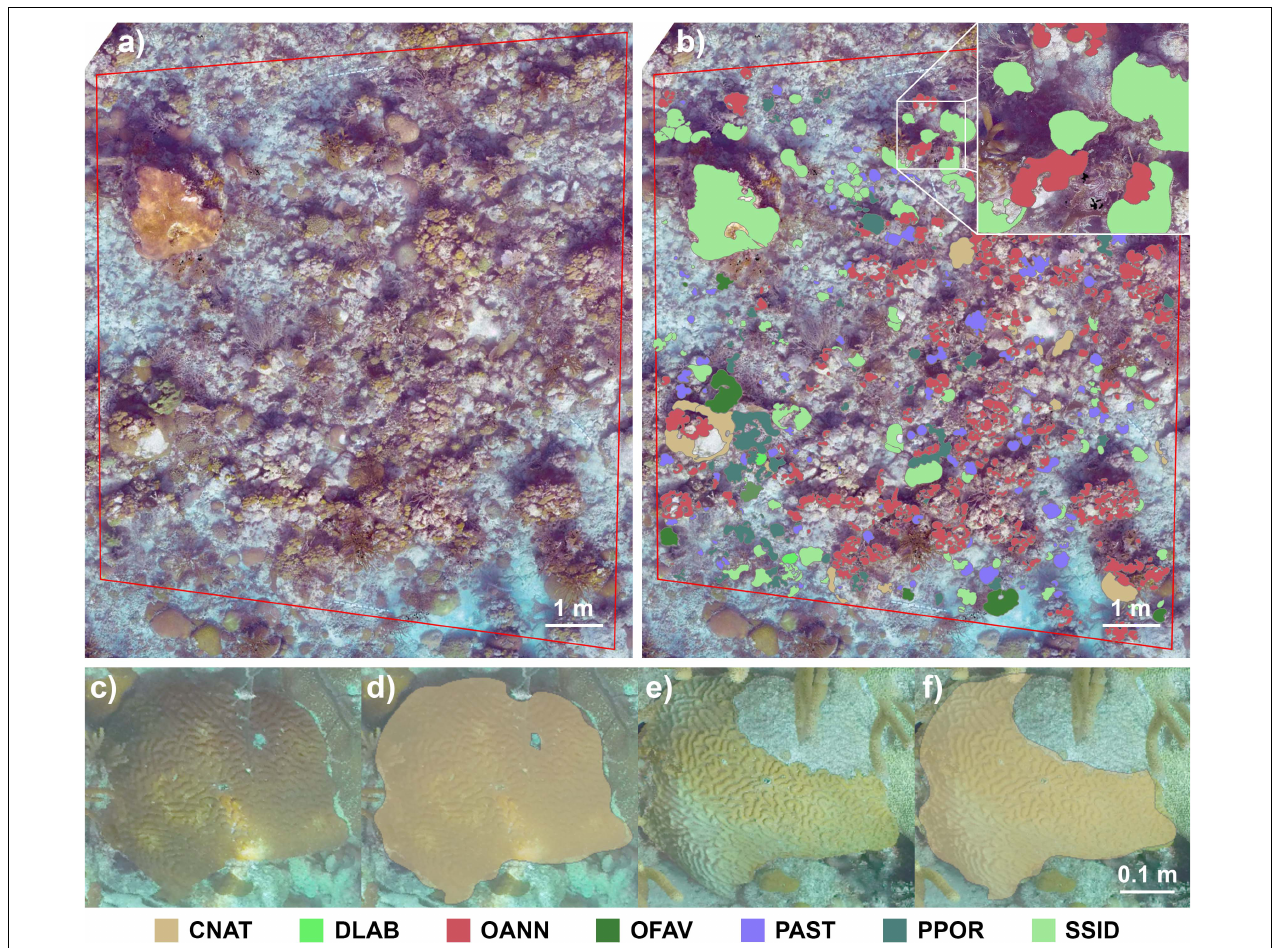
FIGURE 2 | (a) Orthomosaic of one of the six plots analyzed in this study. The red boundary was defined by permanent markers at the site, and all scleractinian coral colonies within this area were included in the analysis. (b) The same orthomosaic with superimposed polygons representing the boundaries of individual coral colonies. A fate-tracked Colpophyllia natans colony in (c) November 2017, (d) with resulting analysis polygon, (e) and the same colony showing partial mortality in September 2019, (f) with its resulting edited polygon. CNAT, Colpophyllia natans ; DLAB, Diploria labyrinthiformis ; OANN, Orbicella annularis ; OFAV, Orbicella faveolata ; PAST, Porites astreoides ; PPOR, Porites porites ; SSID, Siderastrea siderea